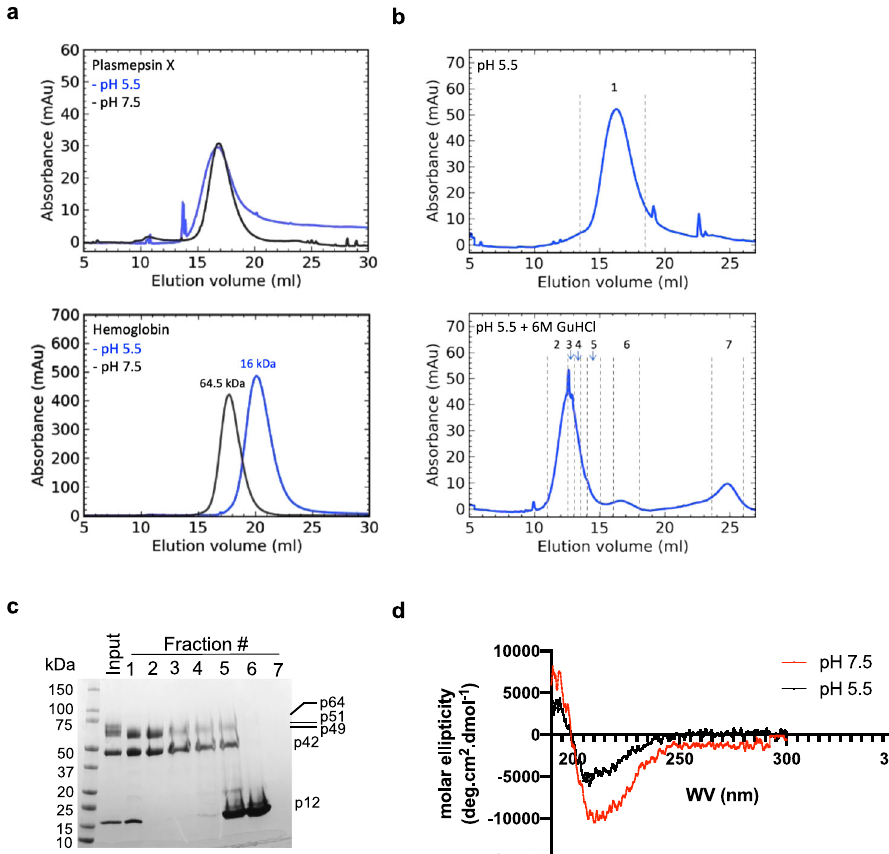
Fig. 4 | The p12 polypeptide remains attached to rPM X under activation conditions. a Overlay of the elution pro fi les of WT rPM X (top) or hemoglobin a (bottom) following size exclusion chromatography at the indicated pH. b Elution pro fi le of rPM X following size exclusionchromatography atpH 5.5 inthe absence (top)orpresence(bottom)of6MguanidineHCl(GuHCl)asadenaturant.Samples were pretreated in the same buffer before loading onto the column. Numbers